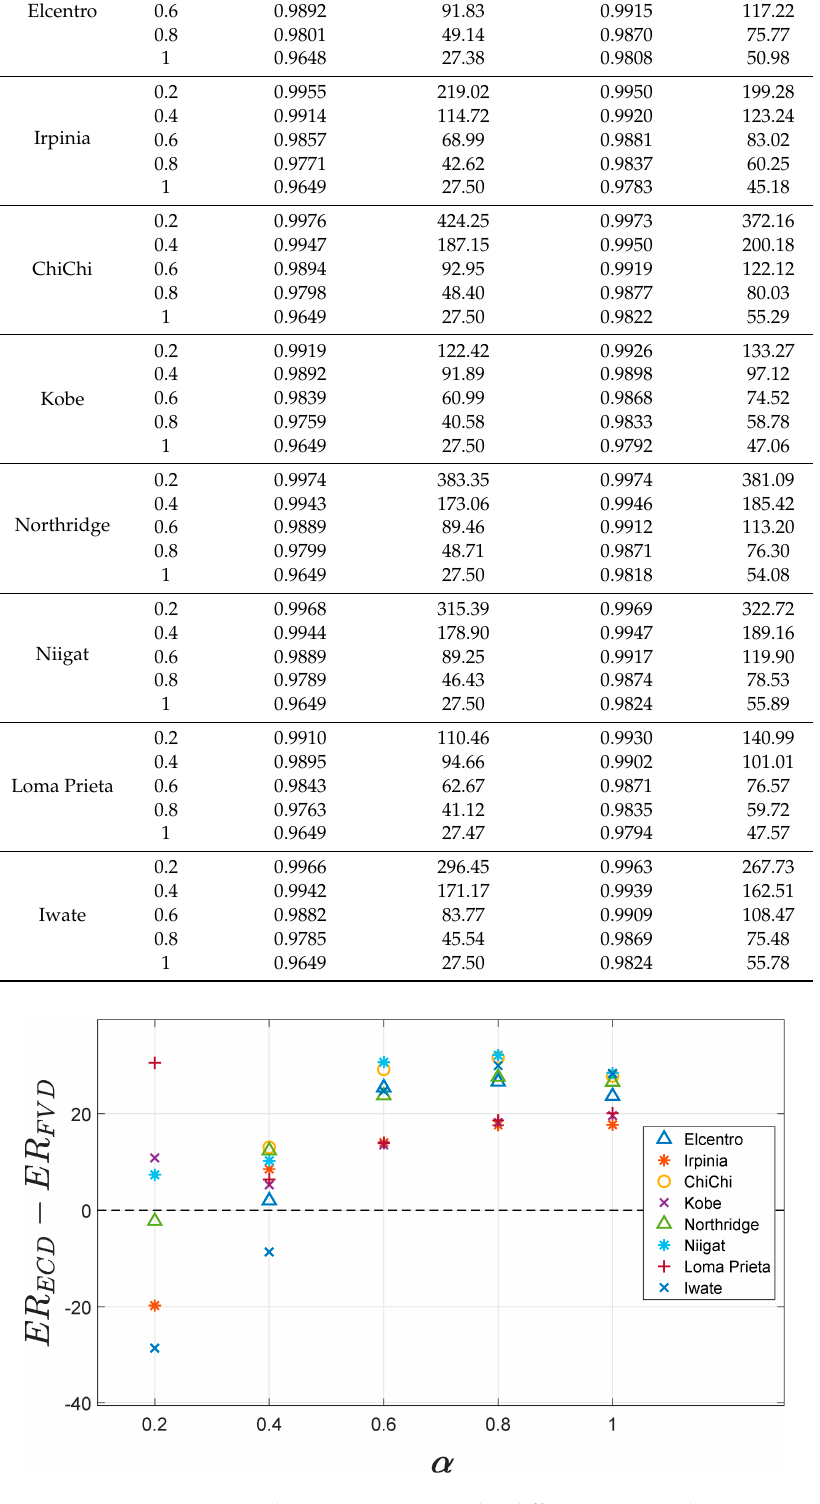
Figure 12. Energy dissipation ratios under di ff erent